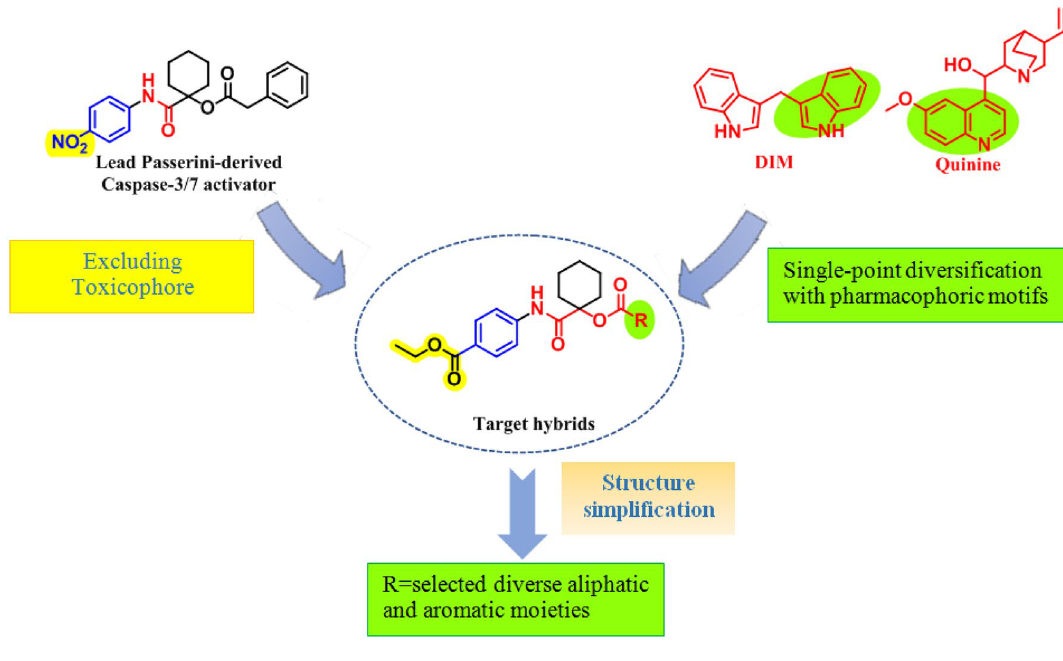
Figure 2. Design rationale of the target Passerini adducts.